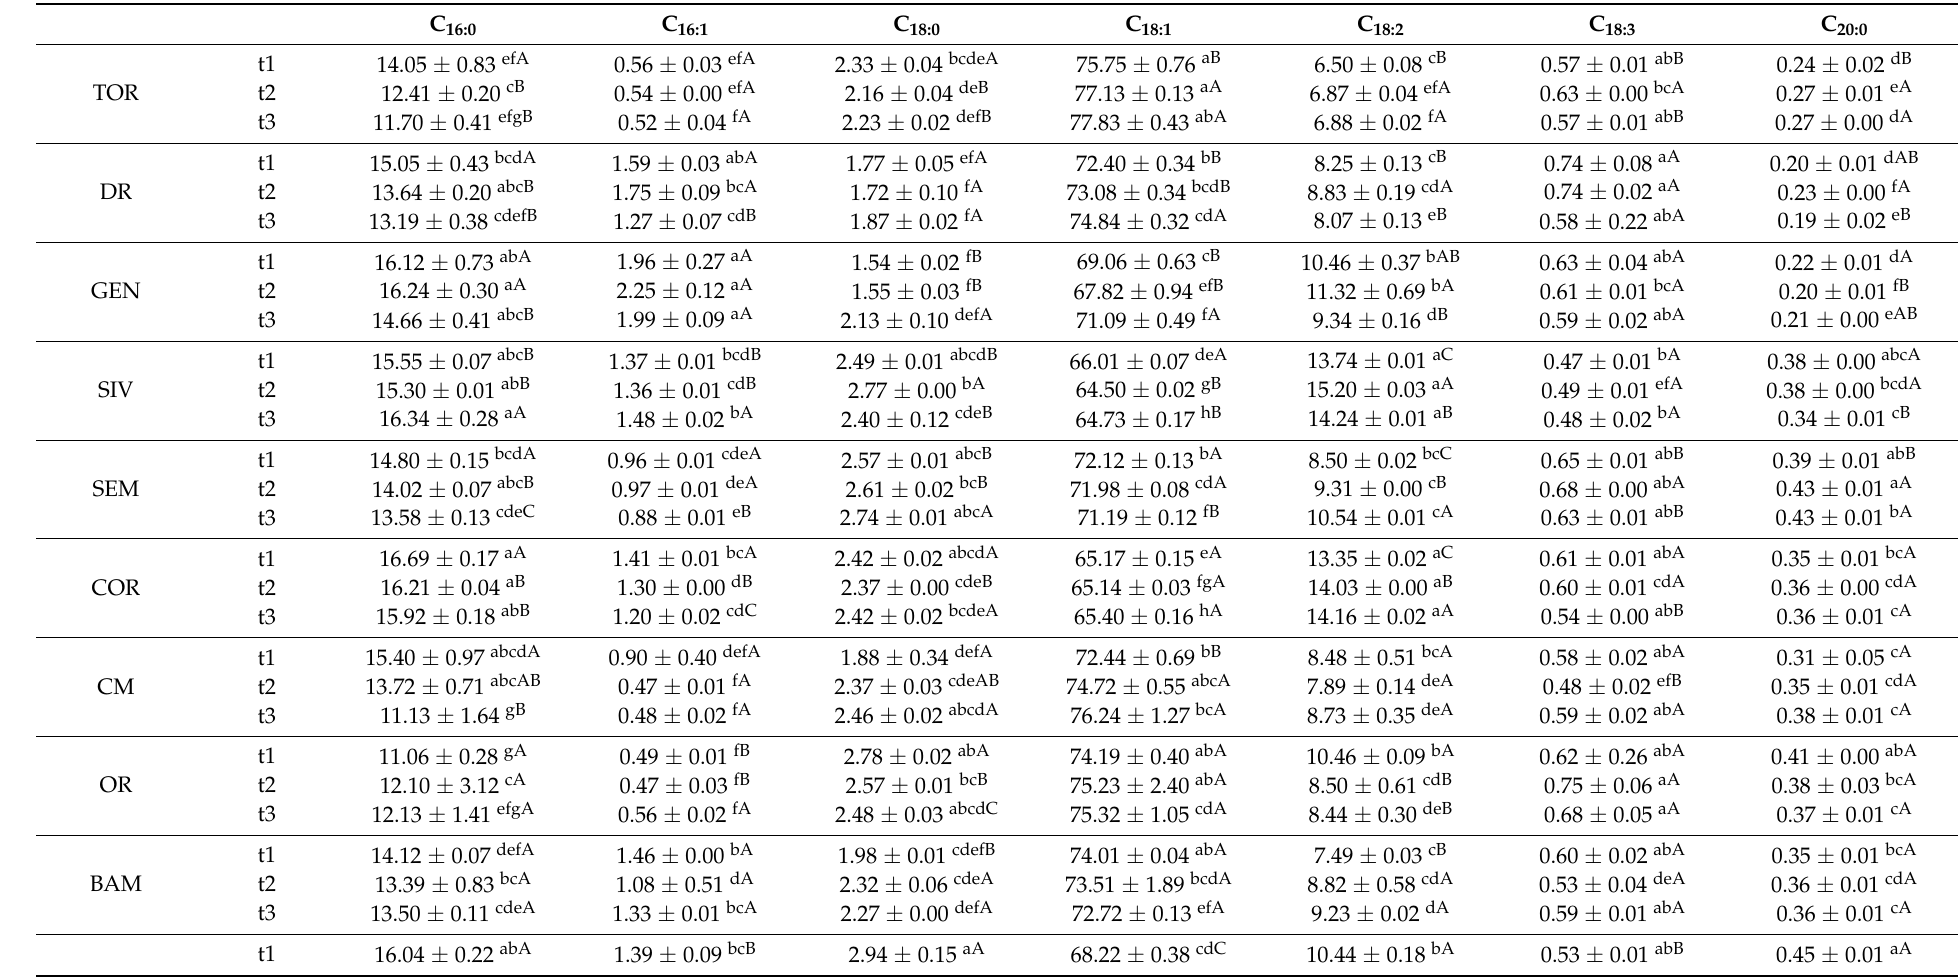
Table 2. Fatty acids (%) of 13 olive oils belonging from minor Italian cultivars harvested at three different maturation stages 1